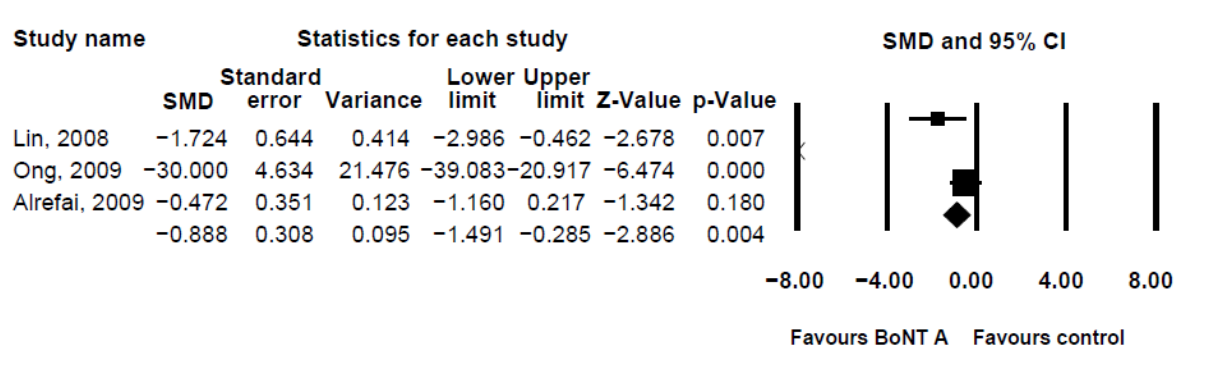
Figure 3. Meta-analysis of drooling frequency and severity scale of botulinum toxin to salivary gland for the treatment of drooling in children with cerebral palsy.